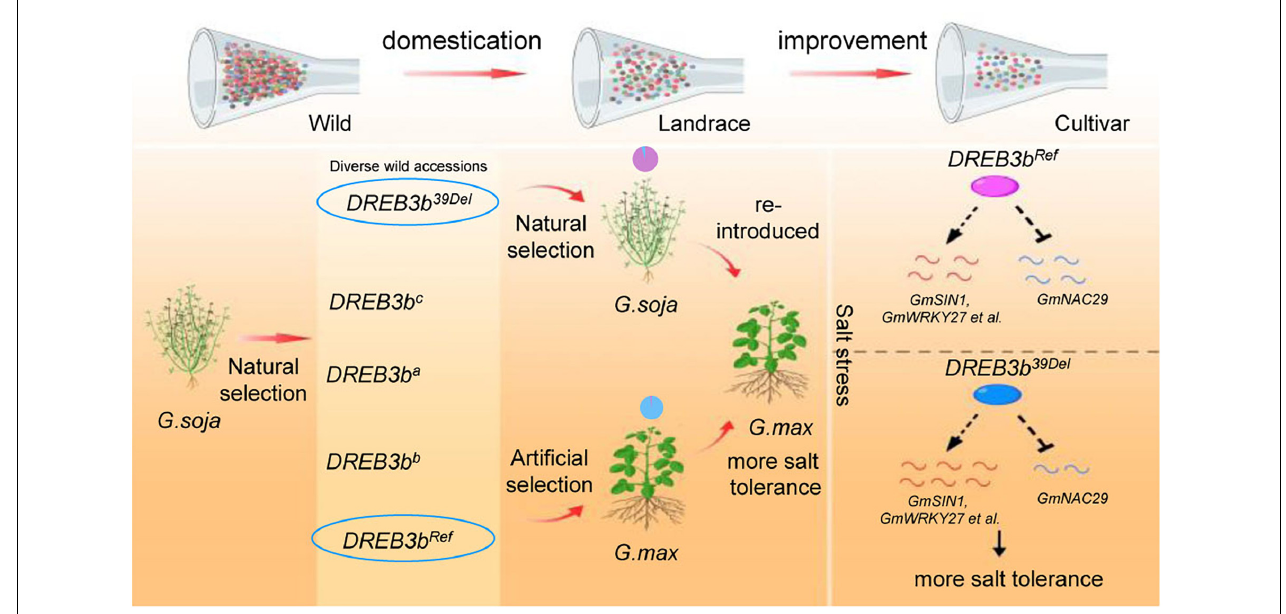
FIGURE 7 | Model of artificial selection in DREB3b in soybean and the underlying mechanism. A large number of potentially advantageous alleles were lost during domestication and cultivar improvement, resulting in lower salt tolerance of cultivated soybean than wild soybean. The DREB3b Ref allele underwent artificial selection in cultivated soybean. The DREB3b Ref allele reduced the salt tolerance of cultivated soybean. DREB3b up-regulates positive regulators of salt tolerance and down-regulates negative regulators of salt